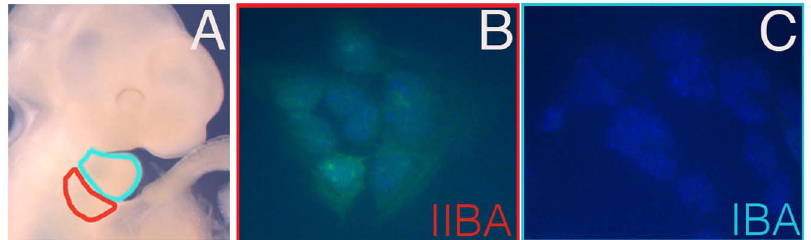
Figure 2. Pcp4 is specifically expressed in IIBA cells. A, Head region of a midgestation mouse embryo, with first and second arch highlighted in turquoise and red, respectively. B,C. Immunofluorescence using Pcp4 antibody (green) stains cells isolated from IIBA (B), but not IBA (C). Nuclear staining is blue (DAPI).